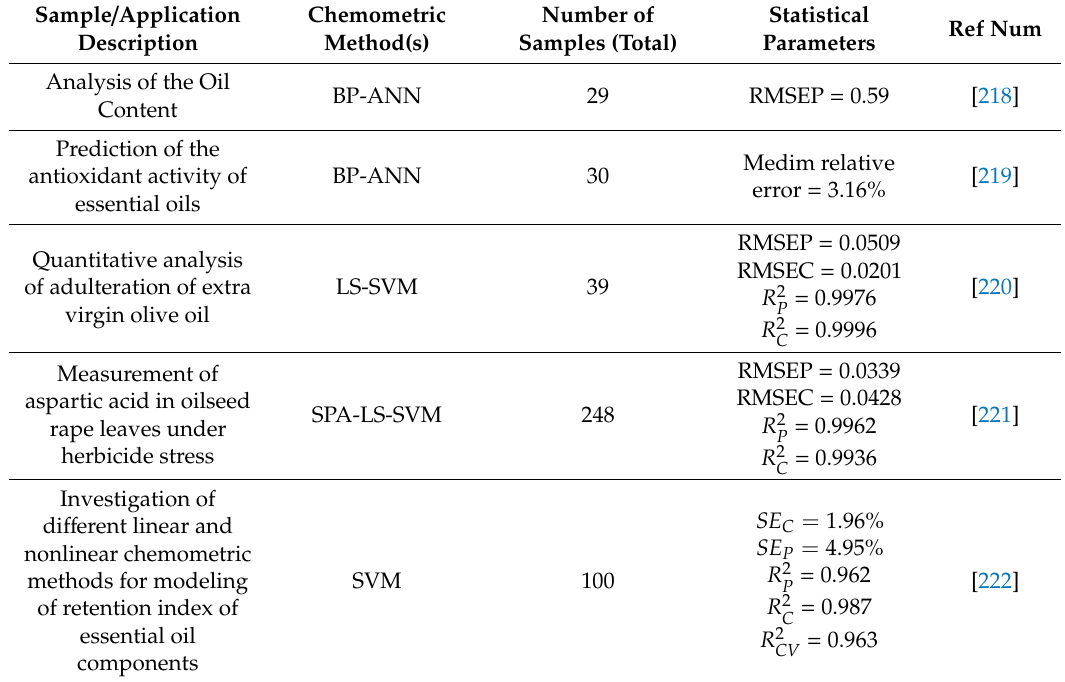
Table 12. Literature related to the use of chemometrics in prediction of properties of